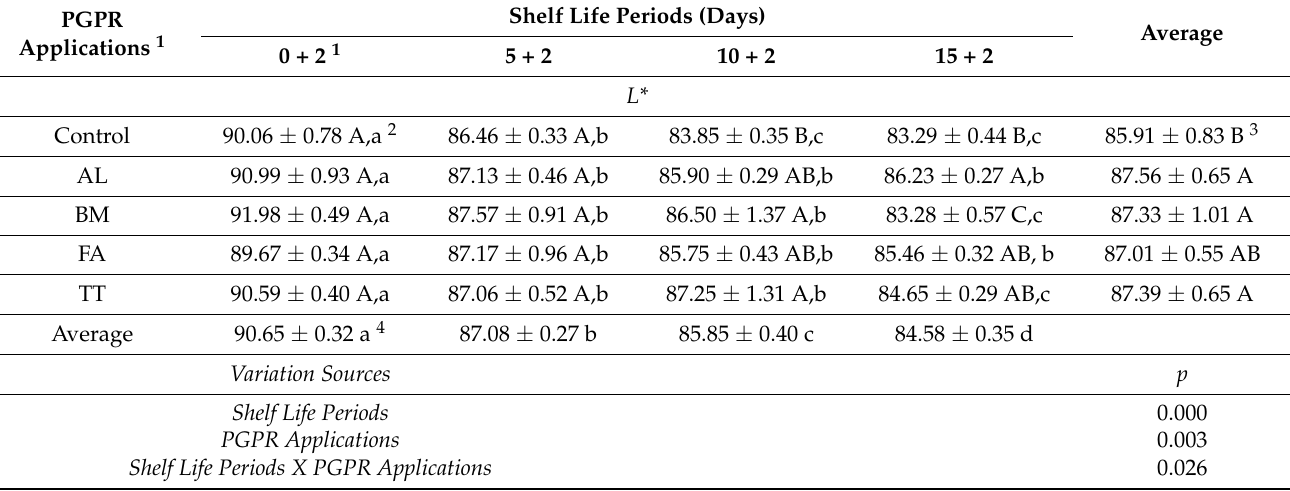
Table 2. The effect of different PGPR applications on color parameters in white button mushroom during shelf life